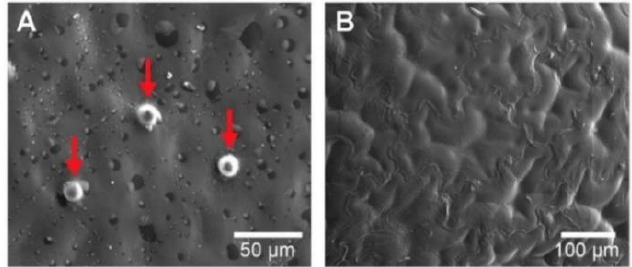
Figure 3. Microphotographs of peel and seed pieces from fresh Physalis purée of via SEM. ( A ) External surface of the skin pieces, red arrows indicate eminences in the exocarp of the fruit (500×). ( B ) External surface of the seed pieces (200×).